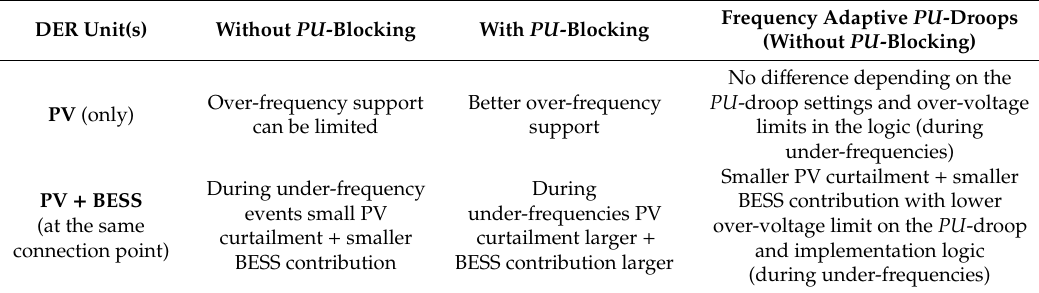
Table 10. Summary about e ff ect of functionalities implementation logic during simulated very low load